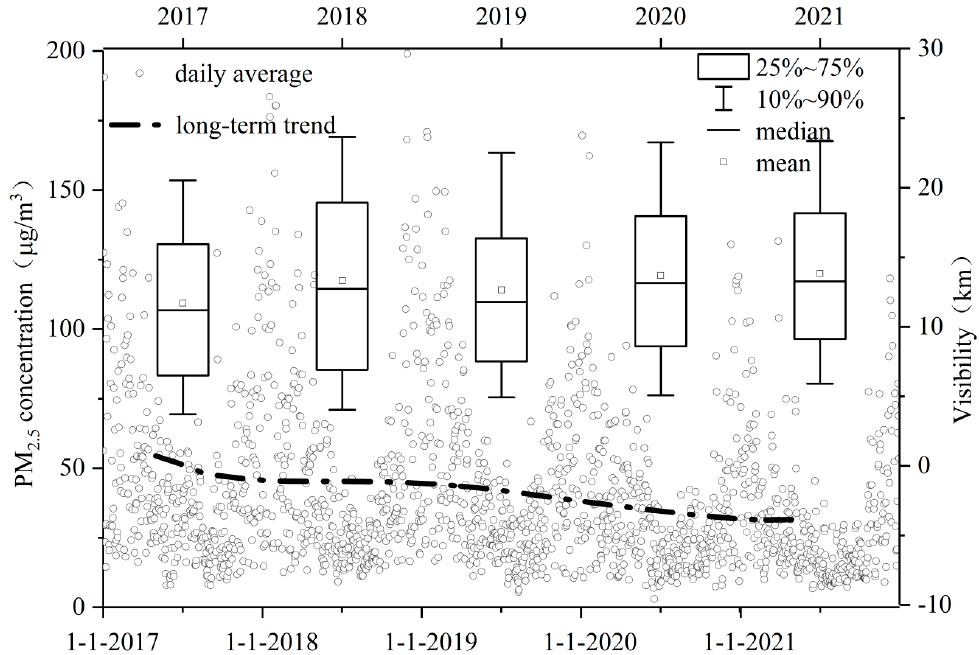
Figure 2. Time series of PM 2.5 and visibility from 2017 to 2021. The hollow circle is the daily average concentration of PM 2.5 . The dashes are the long-term trend of PM 2.5 after KZ filtering. Boxplots show the interannual variation of visibility; the top and bottom short lines indicate 10% and 90% quantiles. The rectangle represents the 25% and 75% quantiles, and the inner short line of the rectangle is the median.